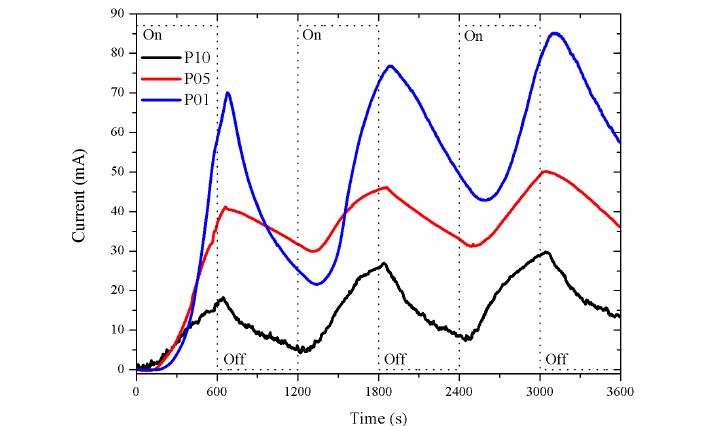
Figure 4. Porous sensor response, Si p-type with 0.01–0.02 Ω · cm resistivity, connected to a 5 V DC supply. The porosity was 45% and the thicknesses of the porous layers were 1, 5, and 10 µ m; labeled as P01, P05, and P10, with dead times of 115, 152, and 247 s,